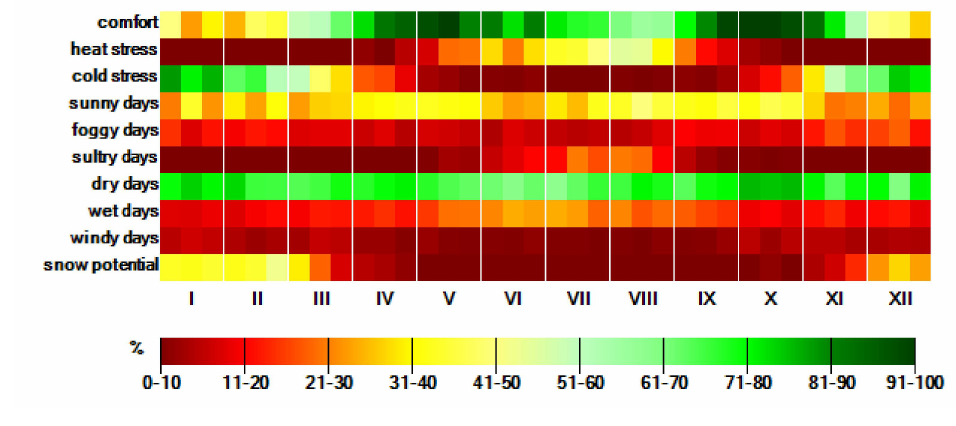
Figure 10. CTIS for L ˛adek-Zdr ó j in 1971–2010.